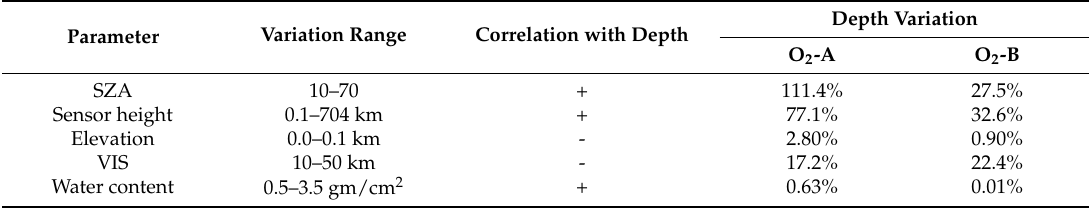
Table 5. Sensitivity analysis. The depth variation is the maximum variation and is calculated as the variation value divided by the base